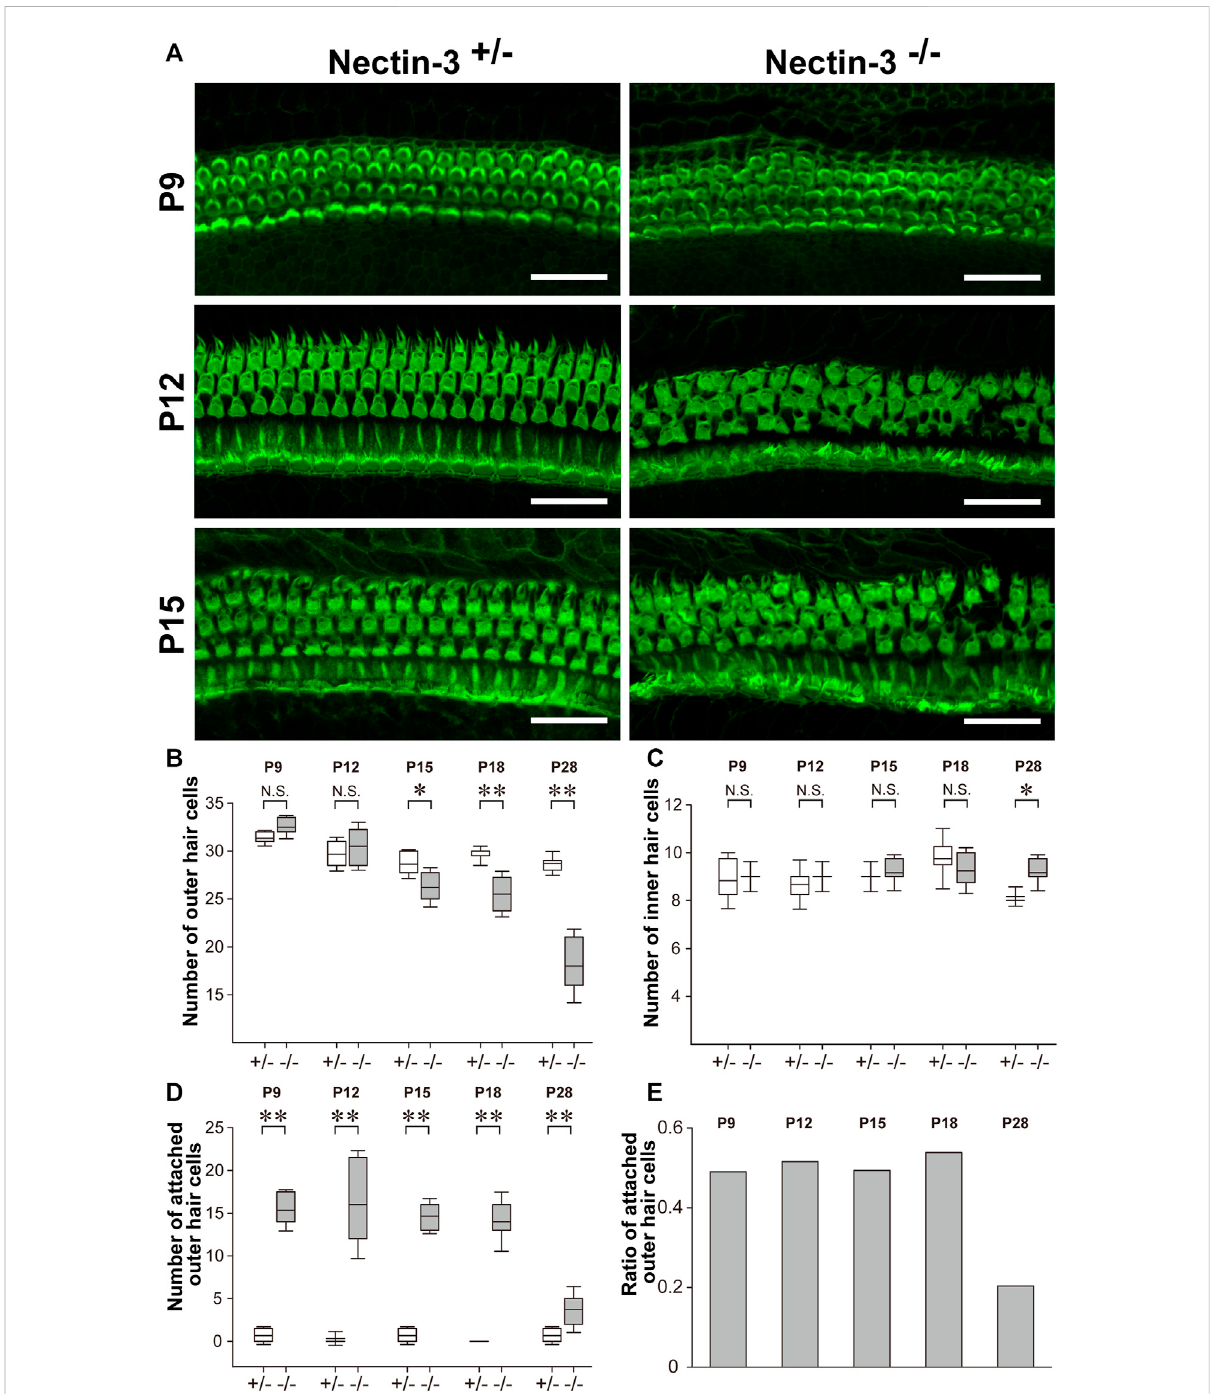
FIGURE 3 Progressive degeneration of outer hair cells in nectin-3 KO mice (A) Immuno fl uorescence signals for F-actin in the middle turn of auditory epithelium in nectin-3 +/ – ornectin-3 − / − onP9,P12,andP15.Scalebarsare30 μ m. (B) Statisticalanalysisofcellnumberchangeoftheouterhaircellinnectin-3 +/ – ornectin-3 − / − miceafterbirthperiods,fromP9toP28.Theboxesinboxplotsshow fi rstandthirdquartiles,whiskersshow9thand91stpercentilesandthemiddlelineofthebox showsthemean.*, p < 0.05;**, p < 0.01,N.S.,notsigni fi cant. (C) Statisticalanalysisofcellnumberchangeoftheinnerhaircellinnectin-3 +/ – ornectin-3 − / − miceafterbirthperiods,fromP9toP28.Thegraphshowsthenumberofattachedouterhaircellsineach fi eld. (D) Statisticalanalysisofcellnumberchangeofthe attachedouterhaircellinnectin-3 +/ – ornectin-3 − / − miceafterbirthperiods,fromP9toP28.Thegraphshowsthenumberofattachedouterhaircellsineach fi eld. (E) The graph shows the ratio of attached outer hair cells in the total outer hair cells in each fi eld of nectin-3 − / − after birth periods, from P9 to P28. Data were collected from three individuals and quanti fi ed using fi ve fi elds in each